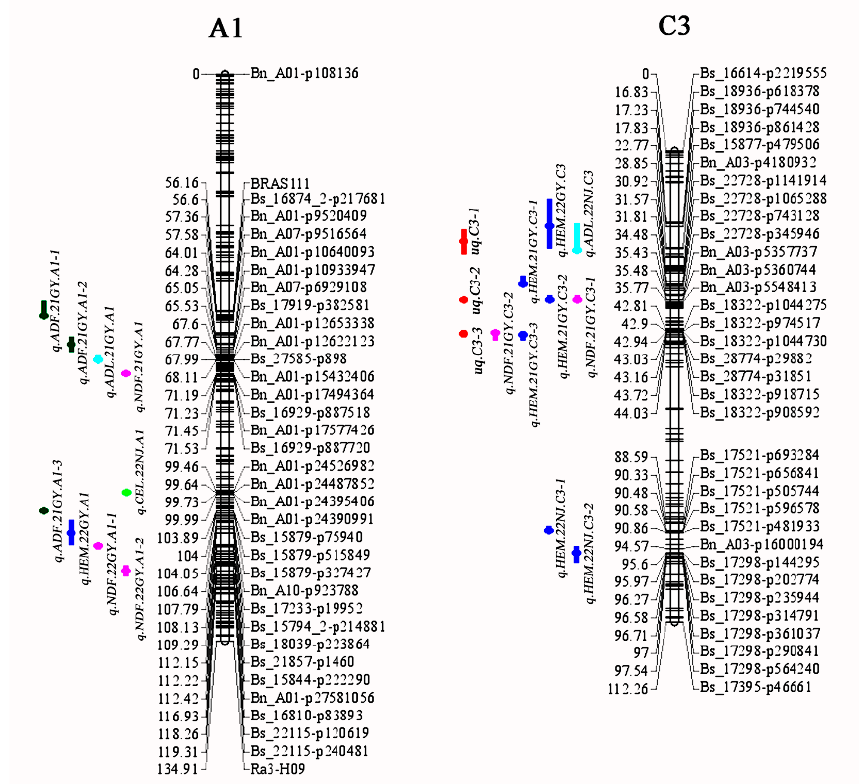
Figure 2. The locations of the identified and unique QTLs for crude fiber components. A1 and C3 represent chromosomes A1 and C3, respectively. The two linkage groups are represented by vertical bars. The locus names are listed on the right of the linkage groups, and the positions are shown on the left.